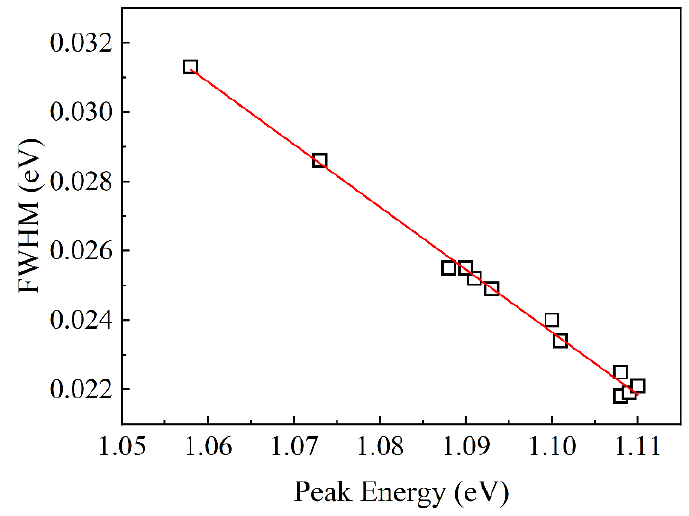
Figure 10. Relationship between photon energy and FWHM for the 2° sample. The red solid line represents the curve fit to the presented data.